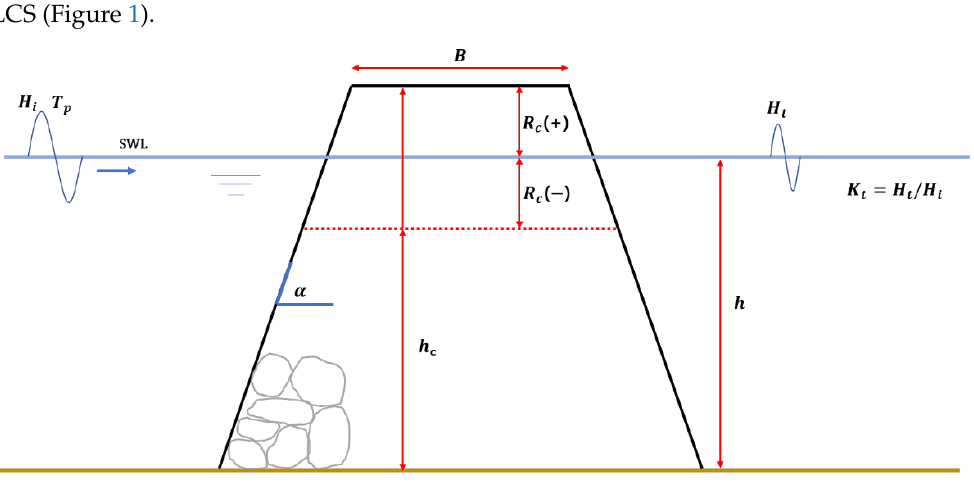
Figure 1. Example of a cross-section of a low-crested and submerged breakwater and the governing parameters. governing